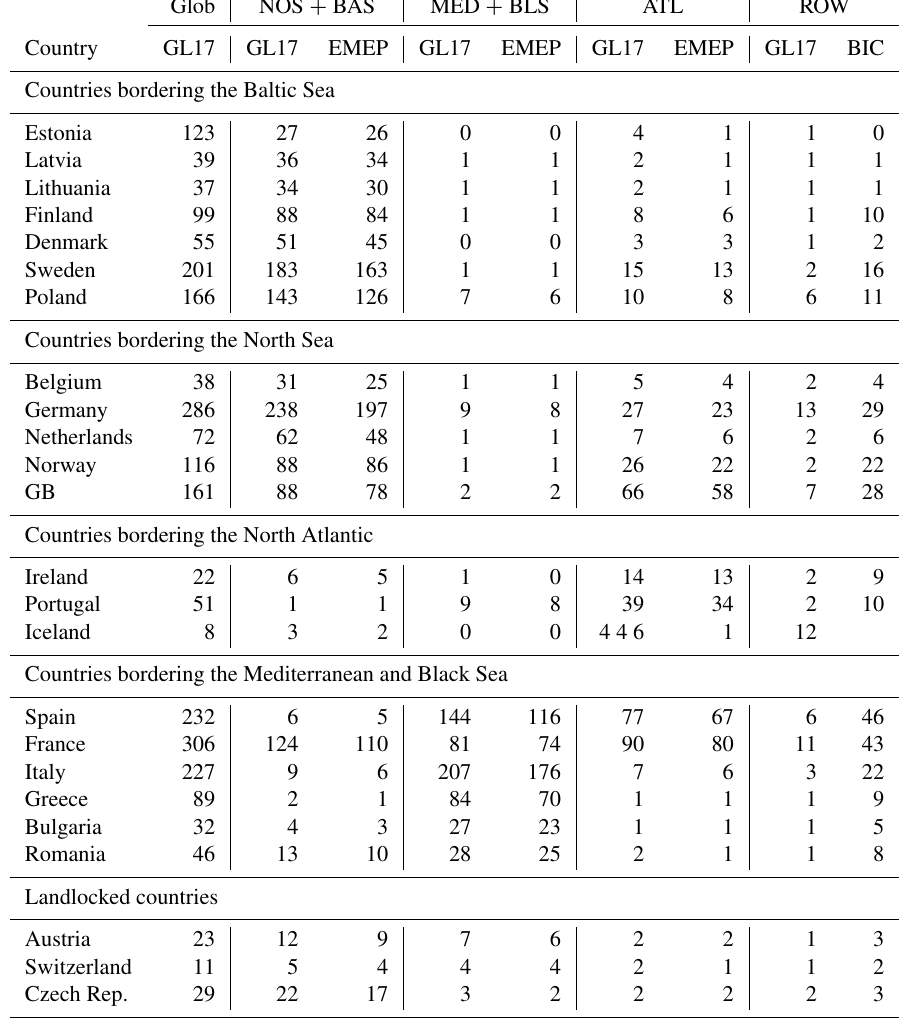
Table 5. Source receptor relationships for depositions of oxidised N “per country” from shipping as calculated by the global model and as reported for the year 2017. Glob is the contribution from all global shipping, NOS + BAS from the North Sea and Baltic Sea combined, MED + BLS from the Mediterranean Sea and Black Sea combined, and ATL from the north-east Atlantic. GL17 is from the global model calculations, and EMEP is from Appendix B in EMEP Status Report 1/2019 (2019) (units: 100Mg of N per 15% emission reduction multiplied by 100 /